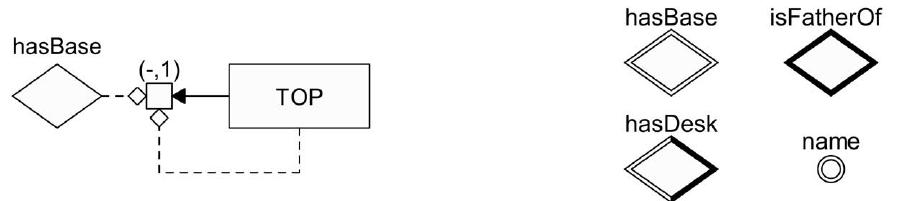
Figure 5. Example of globally functional role represented without the compact notation ( left-hand side ), and examples ( right-hand side ) of globally functional role, inverse functional role, functional and inverse functional role, and functional attribute (resp., top left, top right, bottom left, and bottom right) represented with the compact